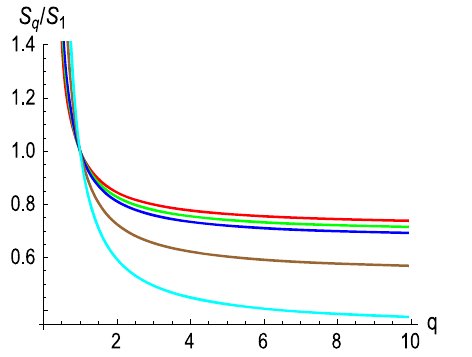
Fig. 4 S q / S 1 as a function of q for various λ . Here C = − 3 / 2 and red, green, blue, brown and cyan curves correspond to λ = − 0 . 19, − 0 . 1, − 0 . 05,0 . 05and0 . 09,respectively.Forthisplot,wehavechosen R = 1, δ = 10 − 4 and L = 2 l